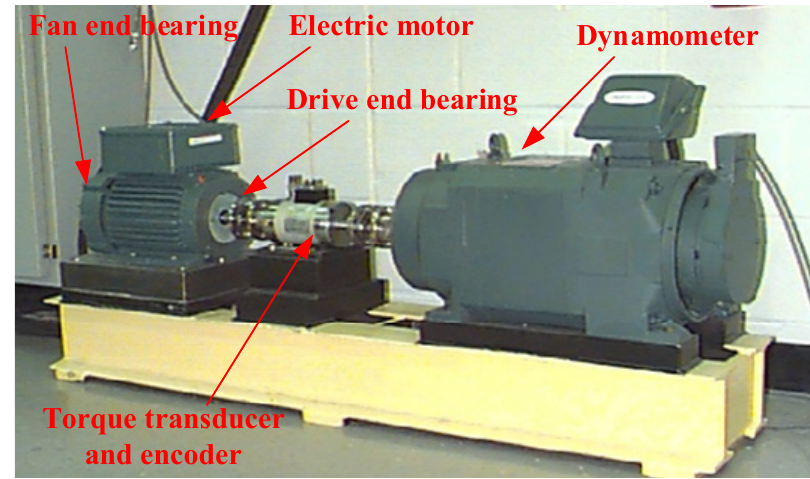
Figure 13. Bearing test bench of Western Reserve University.